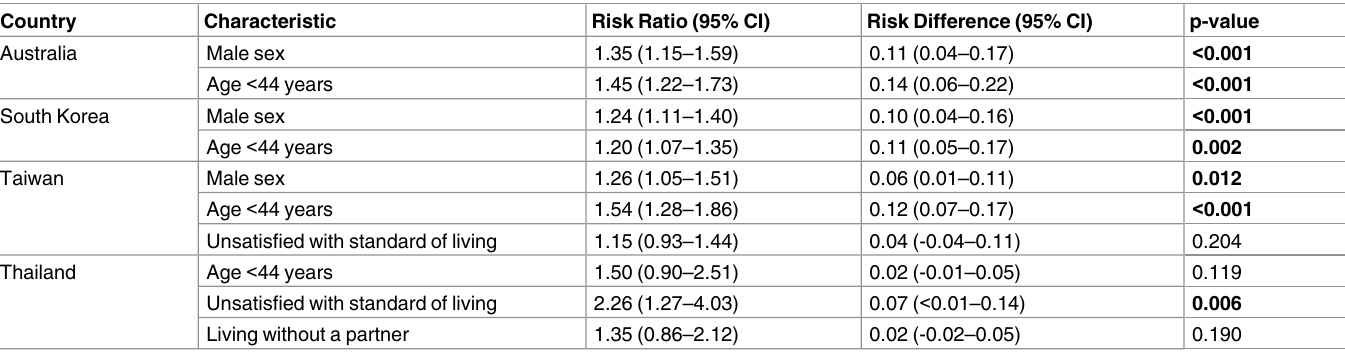
Table 8. Multivariate regression models for lower trust (trust ‘not at all’ or ‘not much’) in Religious Organisations in each country. Country